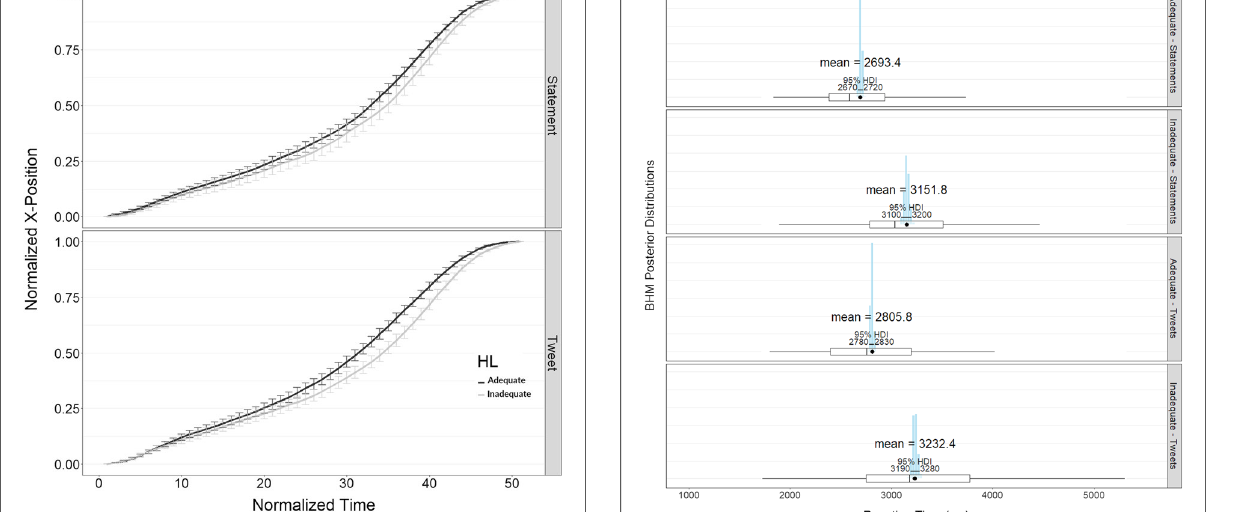
Fig. 3 Normalized X-position by time step. The top panel shows results for statements (Experiment 1). The bottom panel shows results for tweets (Experiment 2). Adequate health literacy scorers are represented by the black line, while inadequate health literacy scorers are represented by the gray line. Adequate scorers made their preference earlier in the trial compared to inadequate scorers for both tweets. Error bars show standard errors